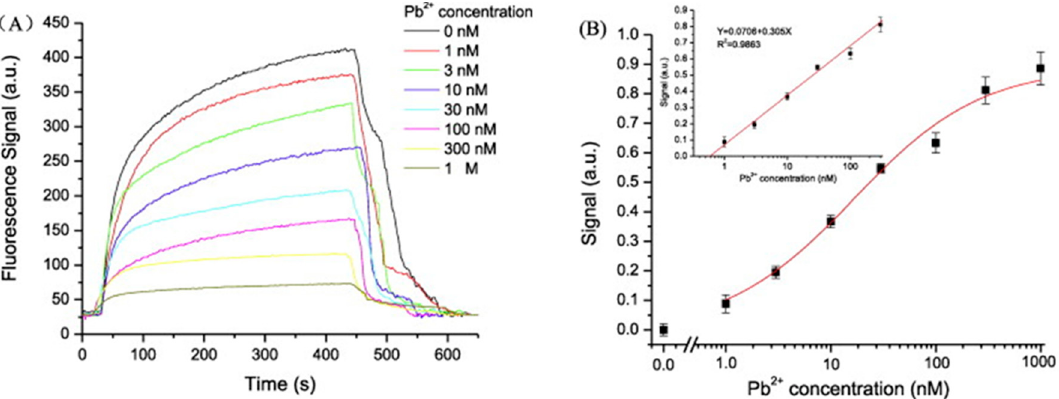
Figure 6. ( A ) Response curve for different Pb 2+ concentrations in the presence of the complementary DNA. ( B ) Logarithmic calibration curve of the sensor. Reprinted with permission from [75].